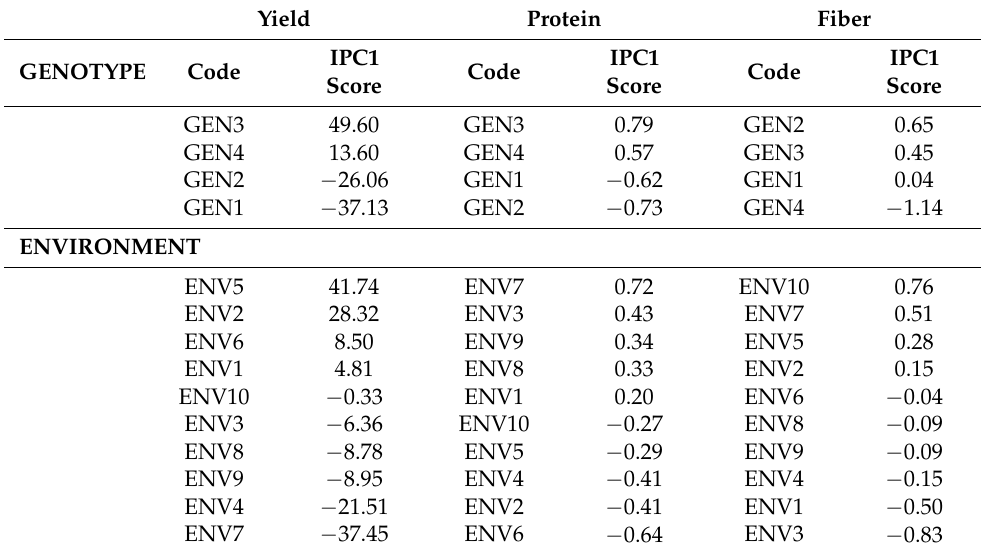
Table 3. Ranking of the genotypes and the environments based on their IPC1 scores for grain yield, protein content and fiber